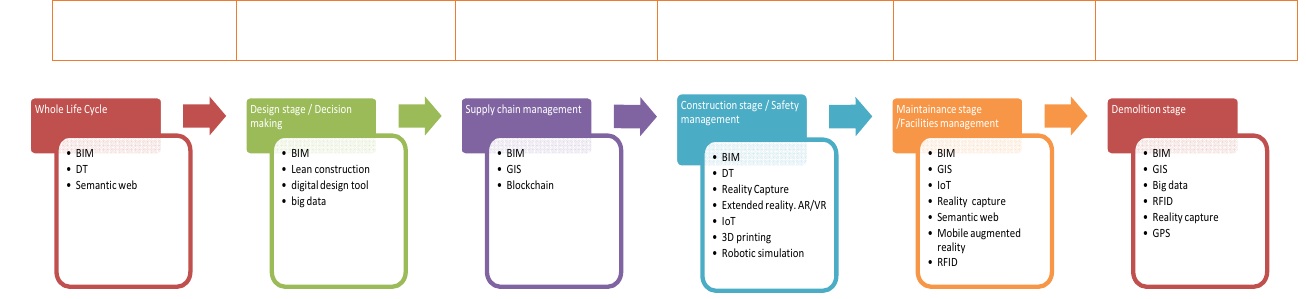
Figure 7. Information management tools at different construction stages. Note: Different stages—whole life cycle [18,52,65,93,94], design stage [10,88,92,95–97], supply chain management [32,57,98], construction stage [61,65,77], maintenance stage [52,53,56,78,85,99,100], and demolition stage [91,101,102].